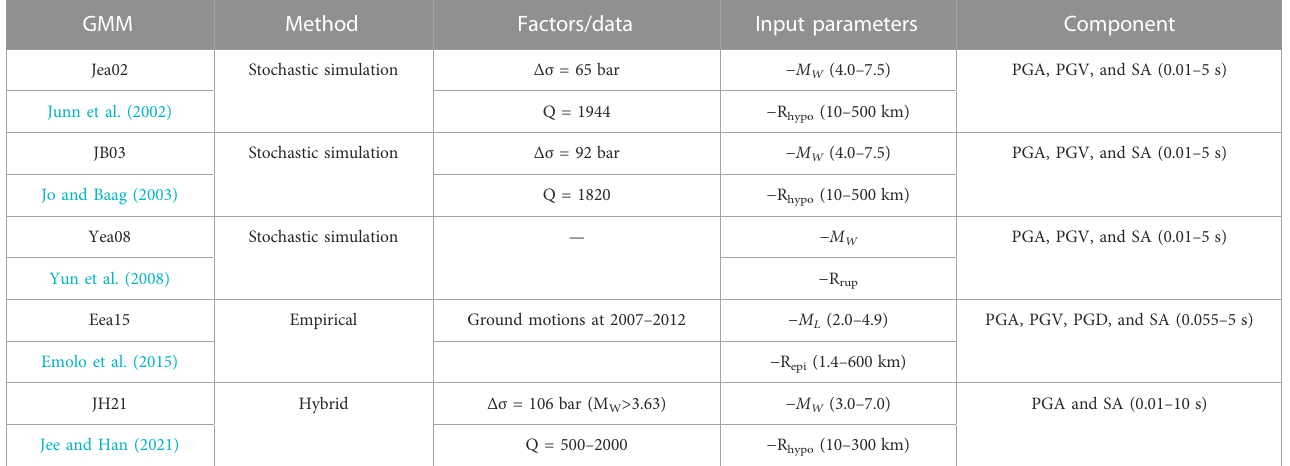
TABLE 1 Comparison of parameters of fi ve Korean-speci fi c GMMs.